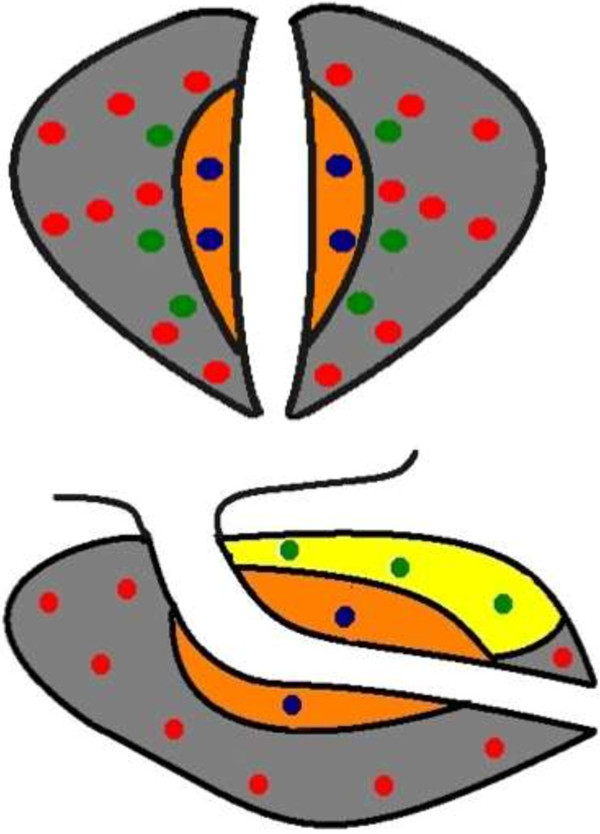
Anterior zone saturation biopsy template. Legend: Circle Gray Peripheral Zone, Circle Red16 Cores from Peripheral Zone, Circle Orange Transitional Zone, Circle Blue 4 Cores from Transitional Zone, Circle Yellow Anterior Zone, Circle Green 6 Cores from Anterior Zone.